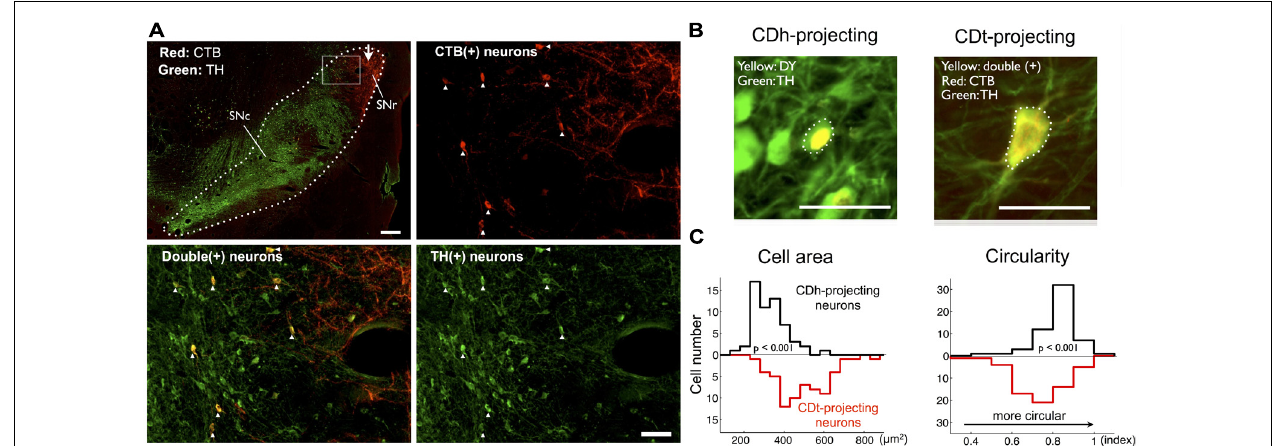
FIGURE 6 | CDt- and CDh-projecting neurons in SNc are dopaminergic. (A) Distributions of CDt-projecting neurons (CTB-positive, red) and DA neurons (TH-positive, green) in monkey SM.The CDt-projecting neurons were clustered in the dorsolateral part of SN (dotted line in top-left section; scale bar: 500 μ m), and this area (box in top-left) is enlarged in the other sections: CTB-positive (top-right),TH-positive (bottom-right), and merged (bottom-left; scale bar: 100 μ m).The merged image (bottom-left) shows double-labeled neurons (yellow signal). White arrow indicates CTB-labeled axon terminals of CDt neurons (top-left). (B) Difference in cell area and